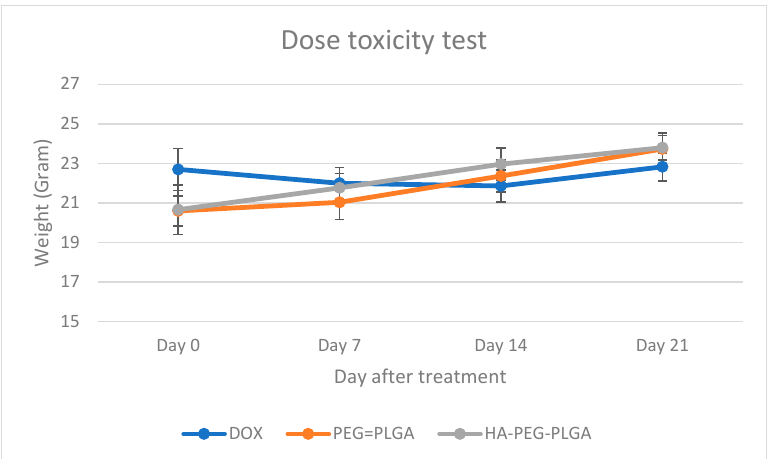
Figure 2. Change in weight of healthy animals after being injected with 25 mg/kg of (DOX: free doxorubicin, PEG-PLGA: Doxorubicin loaded PEG-PLGA nanoparticles, HA-PEG-PLGA: Hyaluronic acid coated Doxorubicin loaded PEG-PLGA nanoparticles).